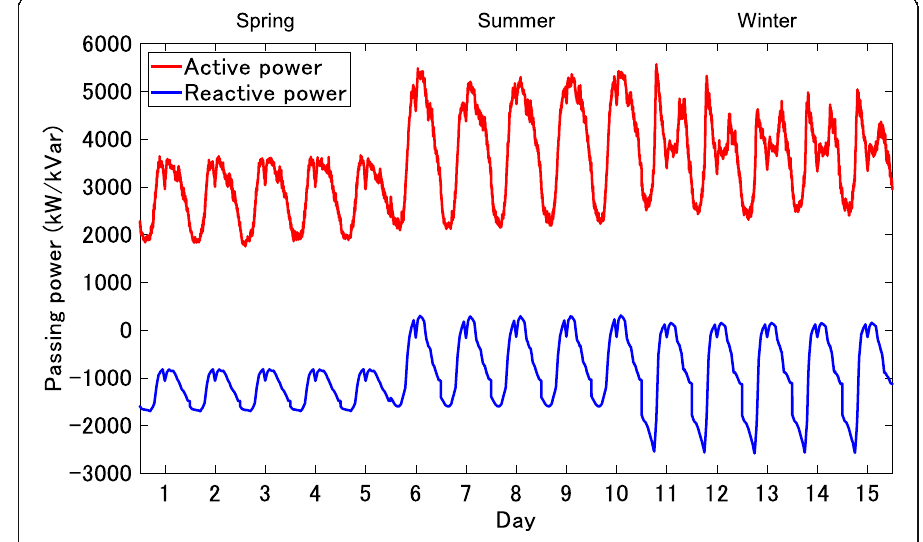
Fig. 4 Passing power through the distribution